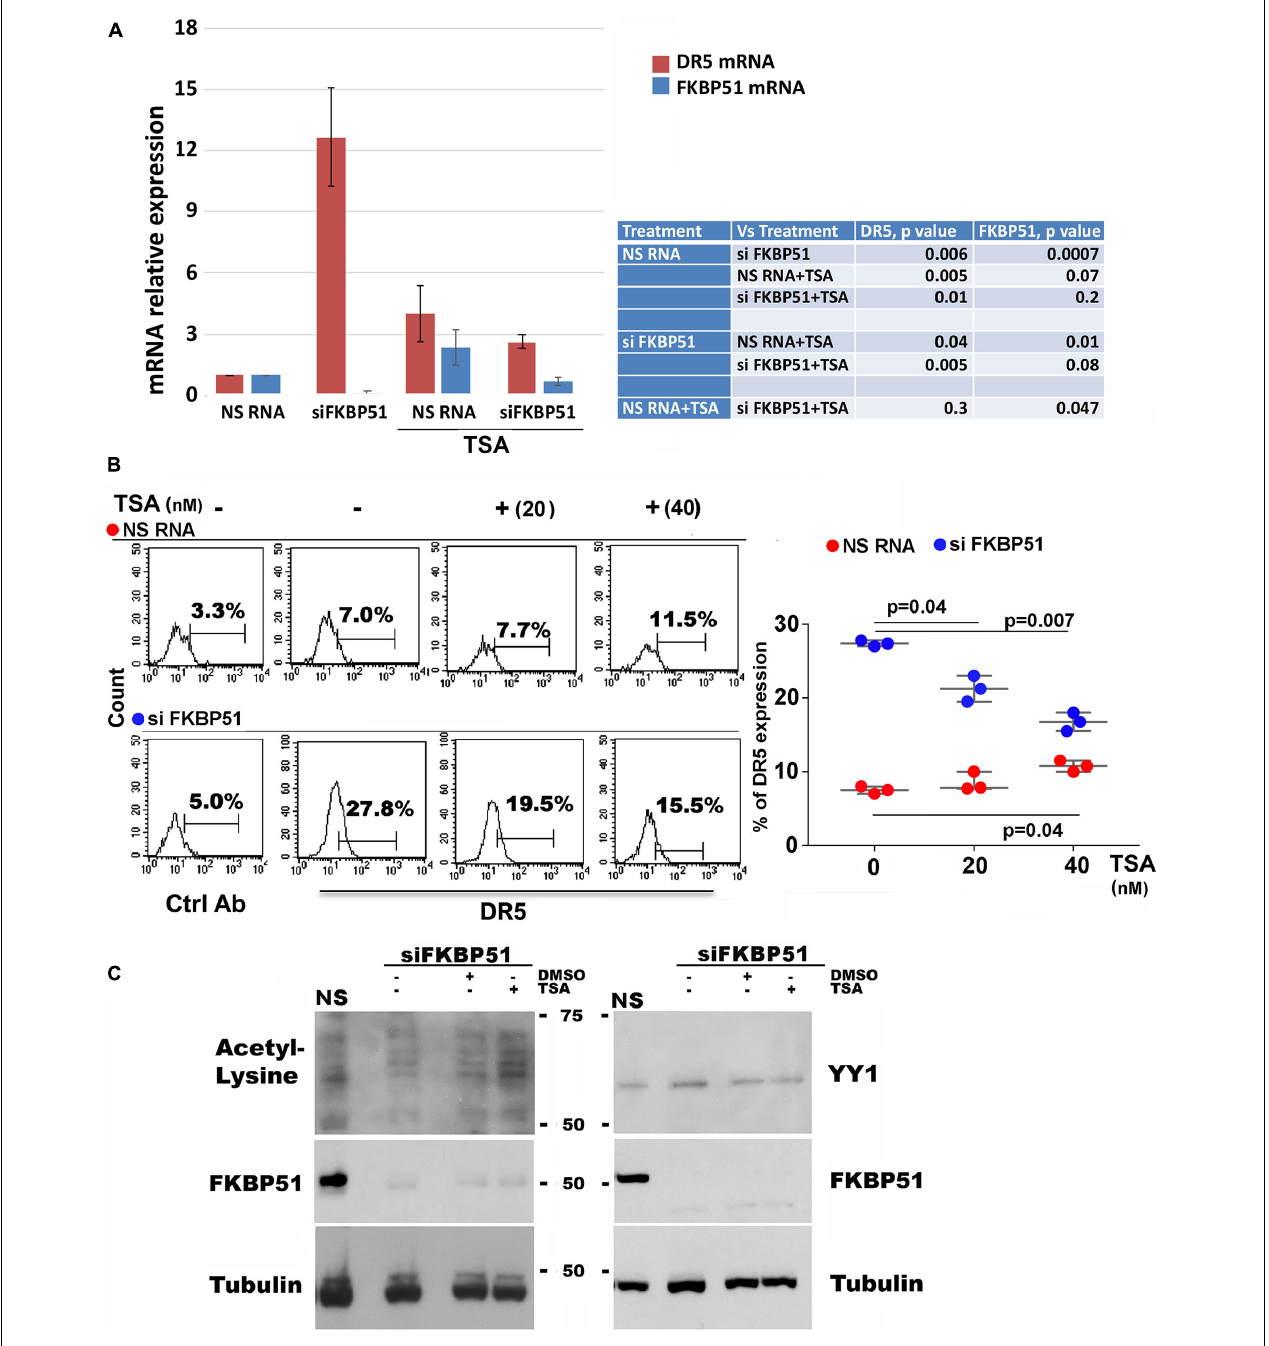
FIGURE 3 | TSA counteracts the effect of FKBP51 silencing on DR5 expression. (A) Analysis by qPCR of DR5 mRNA (red column) and FKBP51 mRNA (blue column) expression in SAN cell line, silenced or not for FKBP51 and cultured with or without 40 nM TSA ( N = 3). (B) Effect of TSA on DR5 expression on SAN melanoma cells silenced or not for FKBP51. Left, flow cytometric histograms of DR5 expression. Right, graphic representation of mean ± SD ( N = 3) of DR5 (%) expression, in response to 20, and 40 nM TSA. (C) Western blot assay (representative of three different experiments) performed with antiacetyl lysine antibody shows a reduced acetylation pattern of FKBP51-silenced (SiFKBP51) A375, in comparison with non-silenced (NS)A375, which was contrasted by